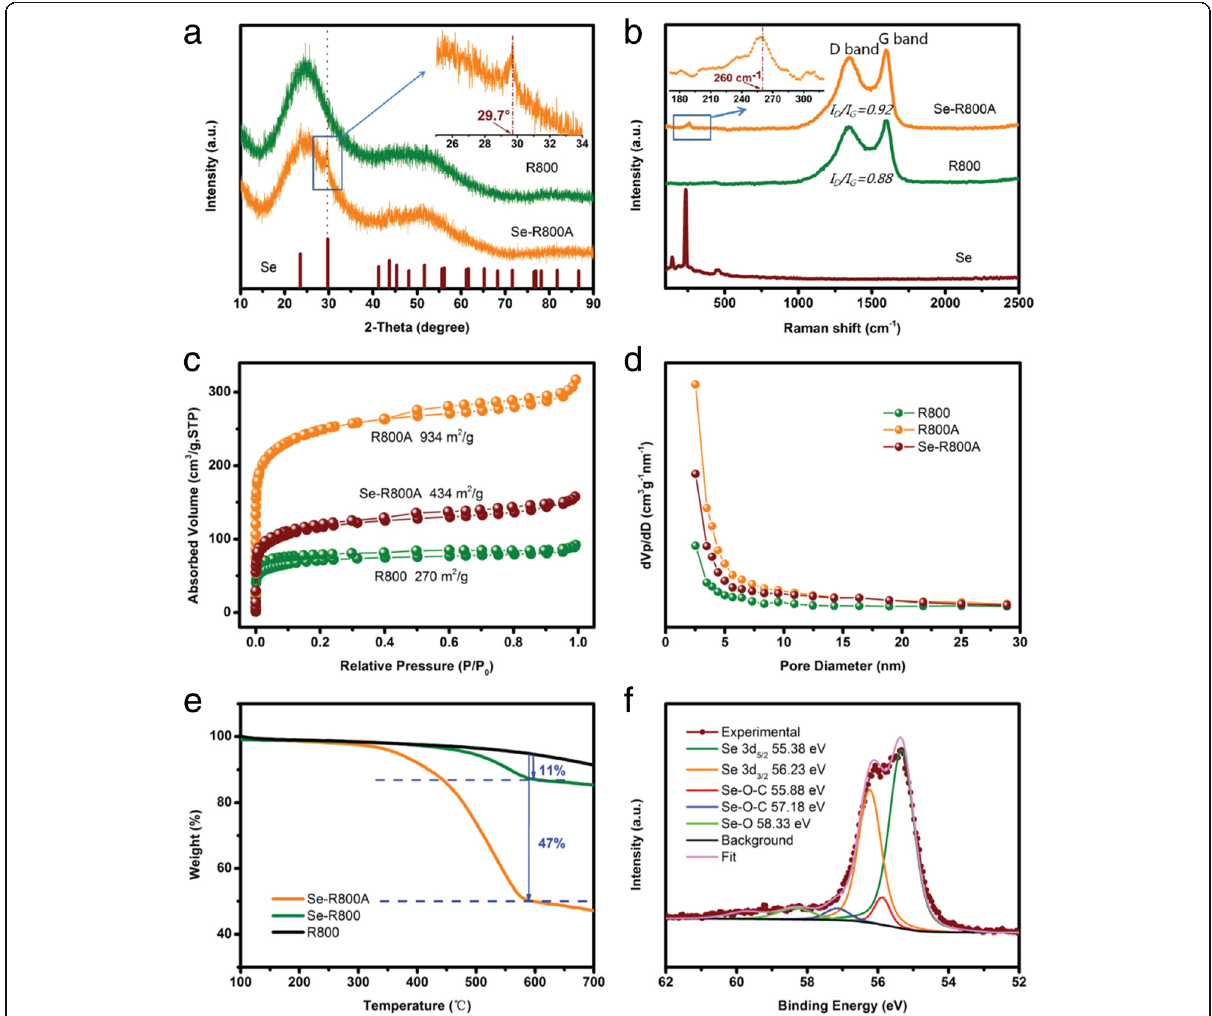
Fig. 4 a XRD patterns and b Raman spectra. c N 2 adsorption/desorption isotherms and d pore-size distribution curves obtained by the DFT method. e Thermogravimetric analysis. f XPS spectra of Se in the